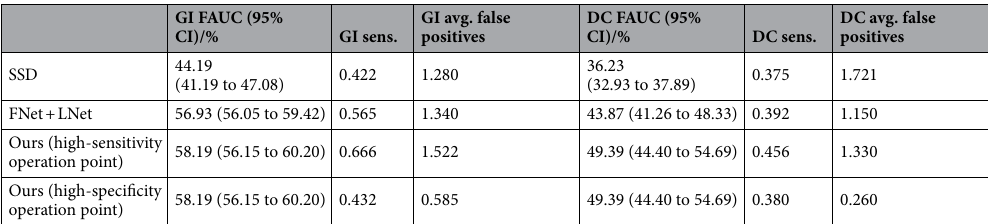
Table 4. Summary of localization performance of different models. detection FAUC (in percentage), bounding-box-wise sensitivity (Sens.), average false positives (Avg. False Positives) are measured for gingivitis (GI) and dental calculus